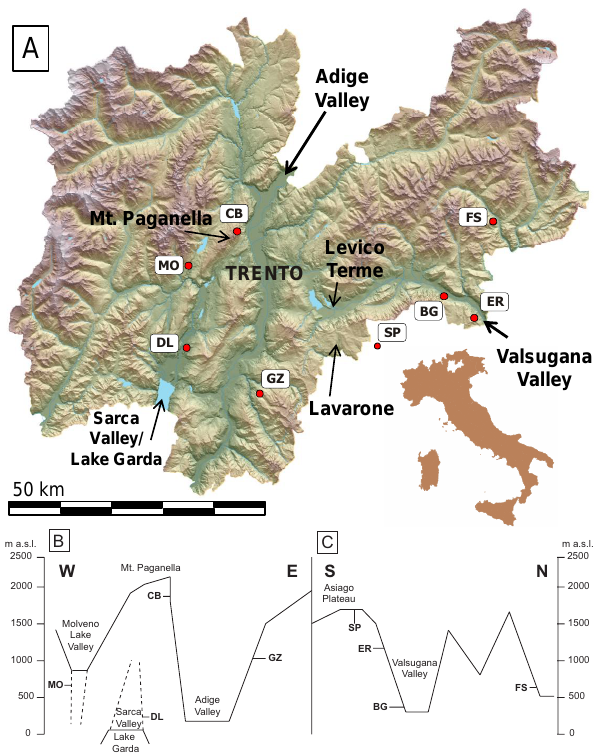
Fig. 1. Location of cave sites in Trentino, N. Italy. (A) Map of Trentino with cave sites and main valleys marked. Note SP cave is just in the Veneto region. Locations of meteorological data (Trento, Levico Terme, Lavarone and Mt. Paganella) also indicated. (B) Schematic cross-section of topography to show the relative alti- tudes and locations of the cave sites in and around the Adige Valley. Internal valleys are noted with dashed lines. (C) Schematic cross- section of caves in the Valsugana Valley. Altitudes are to scale, hor- izontal length is schematic. Note that the Asiago Plateau is located on the map in the same area as the SP cave and